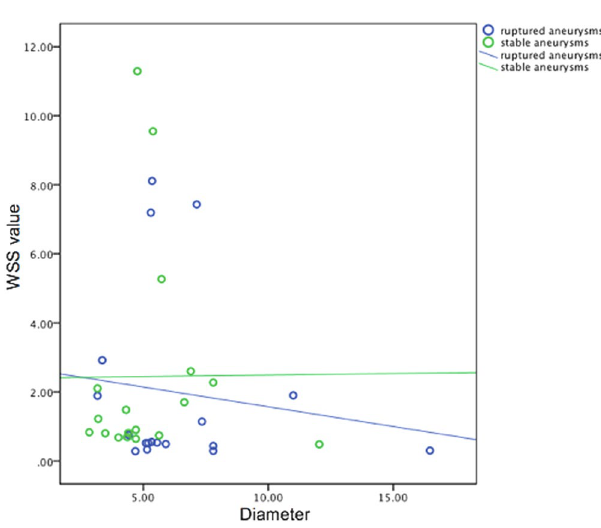
Figure 6. Scatterplots showing the interaction between WSS and aneurysm diameter in unruptured and ruptured